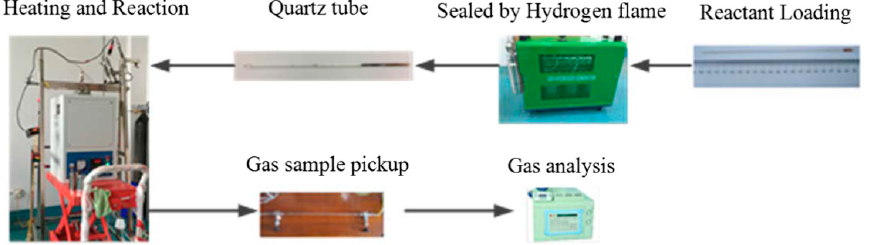
Figure 3. Supercritical water gasification experimental procedure with a micro quartz batch reac- tor [75].